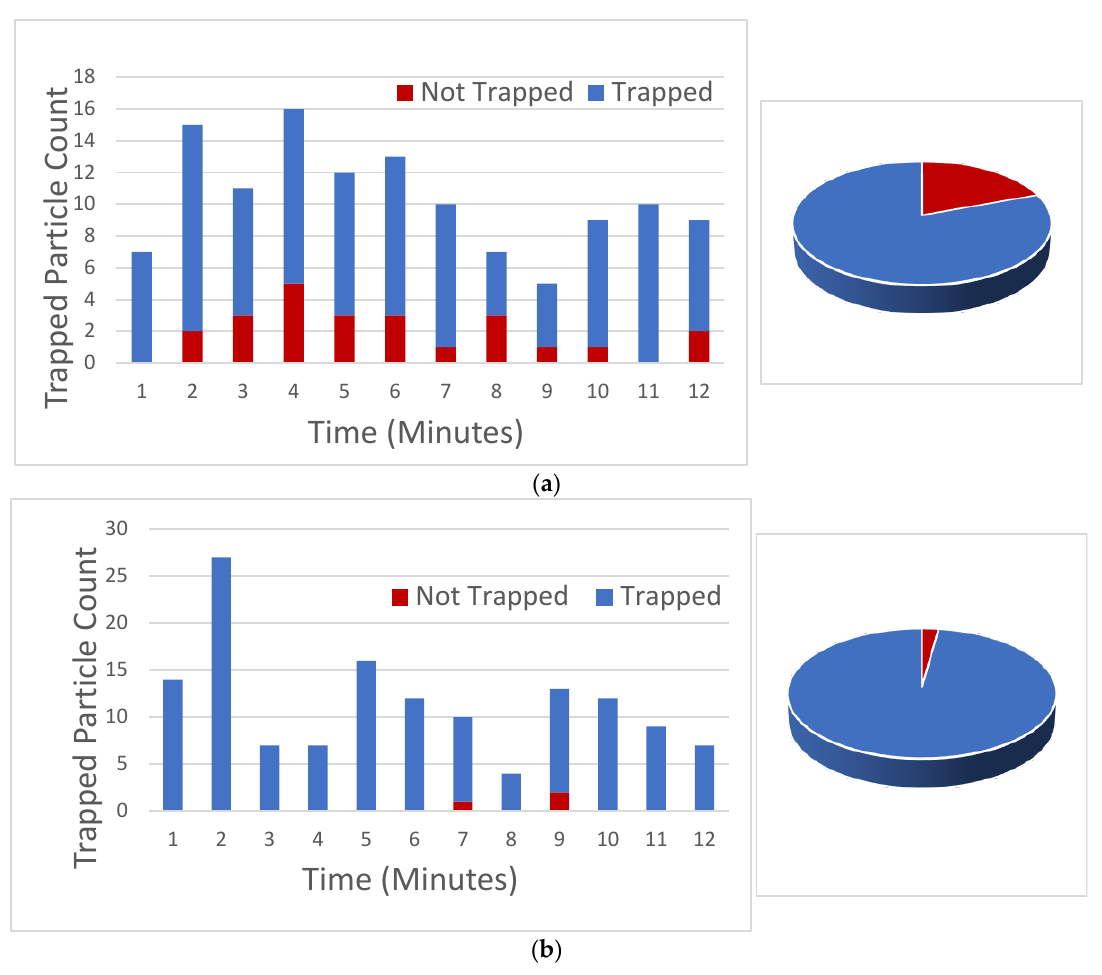
Figure 11. Trapping efficiency experiment for orthogonal force design ( a ) and gradient force design ( b ) over a given time interval. Particles trapped are recorded in blue while non-trapped particles are shown in red.